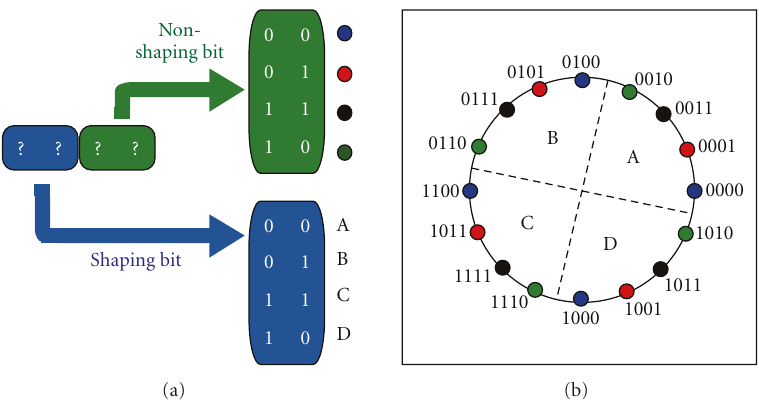
Figure 6: D-Gray labeling example for 16-PSK ( n s = 2). (a) Construction procedure. (b) D-Gray labeling where the shaping bits choose MSB (one of the regions A, B, C, and